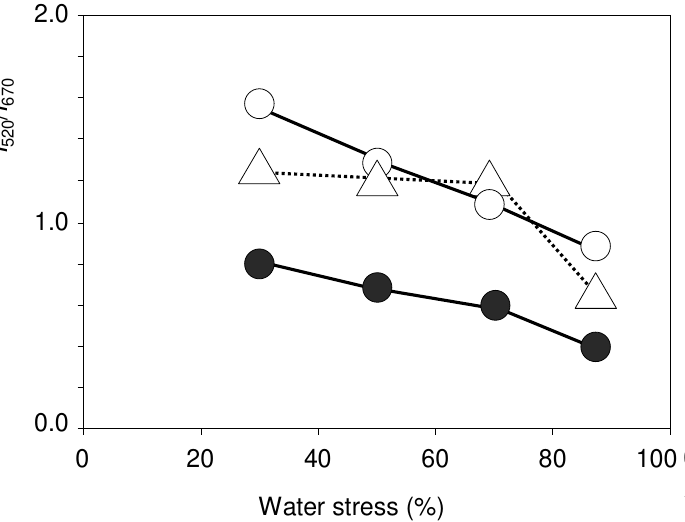
Figure 9. Variation of the I 520 / I 670 peak current ratio determined in voltammograms such as in Figure 2 (from 3–5 replicate measurements) with the percentage of water stress for Peru (circles), Pintat (solid circles) and Ull the Perdiu (triangles).